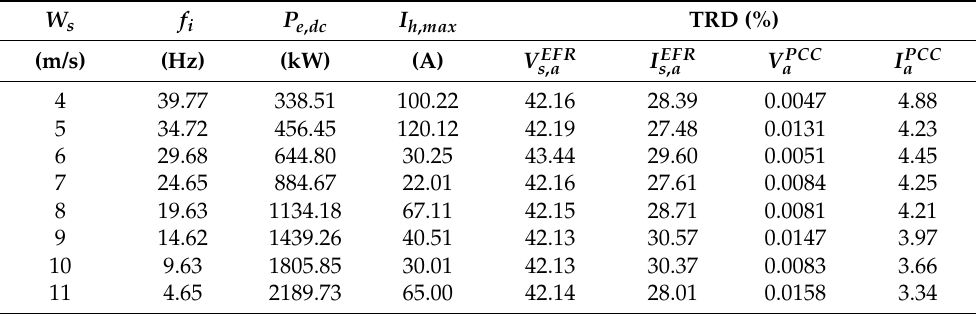
Table 2. Relationship between the wind speed ( W s ), EFR frequency ( f i ), maximum harmonic or interharmonic current in PCC ( I h , max ), dc part of the electromagnetic power ( P e , dc ), Total Rated Distortion (TRD-%) of EFR armature, and PCC currents and voltages. W s f